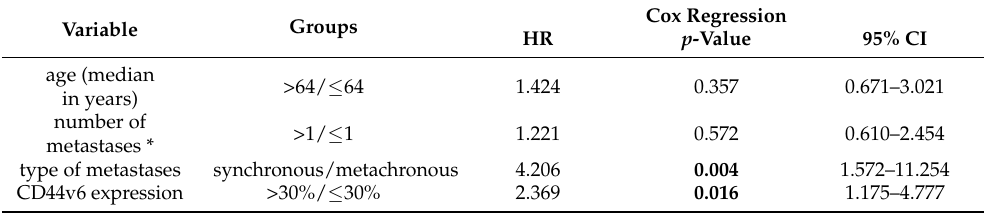
Table 4. Multivariate Survival Analysis of CD44v6 Expression in Colorectal liver Metastases.